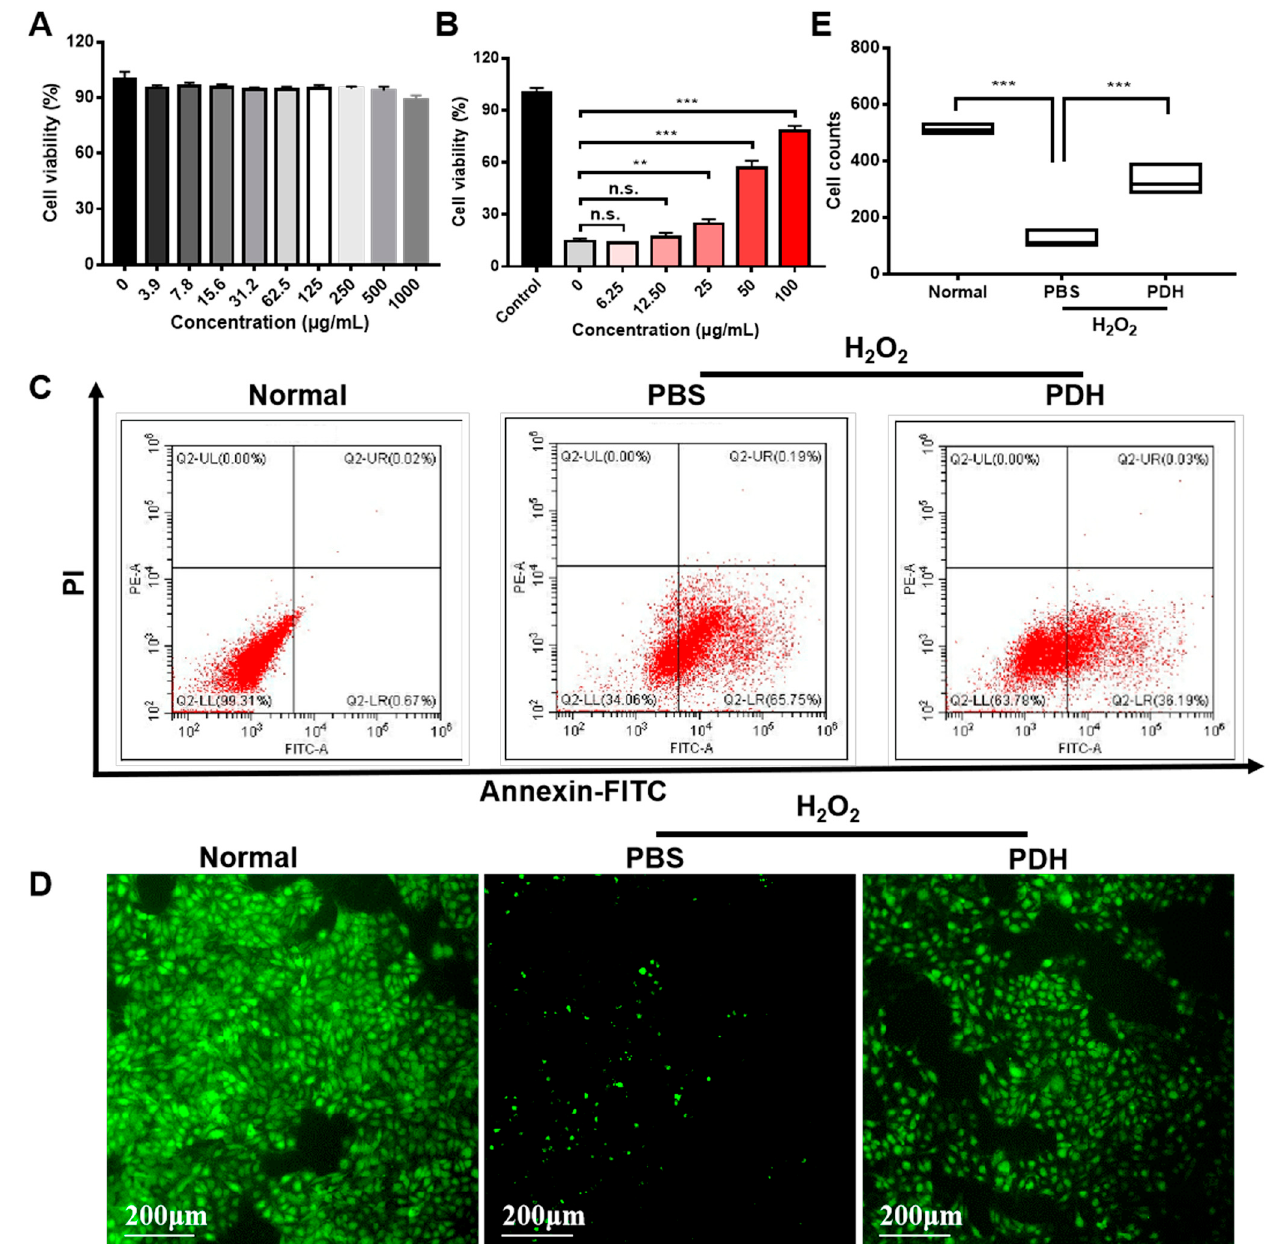
Figure 2. In vitro therapeutic effect of PDH nanoparticles. ( A ) The cell viability of PDH nanoparticles in normal HUVECs detected by MTT assay. ( B ) The cell viability after treatment with different concentrations of PDH nanoparticles detected by MTT assay. ( C ) The annexin-FITC and PI staining of HUVECs after different treatments evaluated by flow cytometry. The first quadrant indicates living cells. The second quadrant indicates early apoptotic cells. The third quadrant represents late apoptotic cells. The fourth quadrant shows the necrotic cells. ( D ) Living cells (labeled with calcein AM) after different treatment with PDH. ( E ) Cell count in Figure 2D measured by image J. (n.s. is non-significant, ** p < 0.01, *** p < 0.001, n = 3).